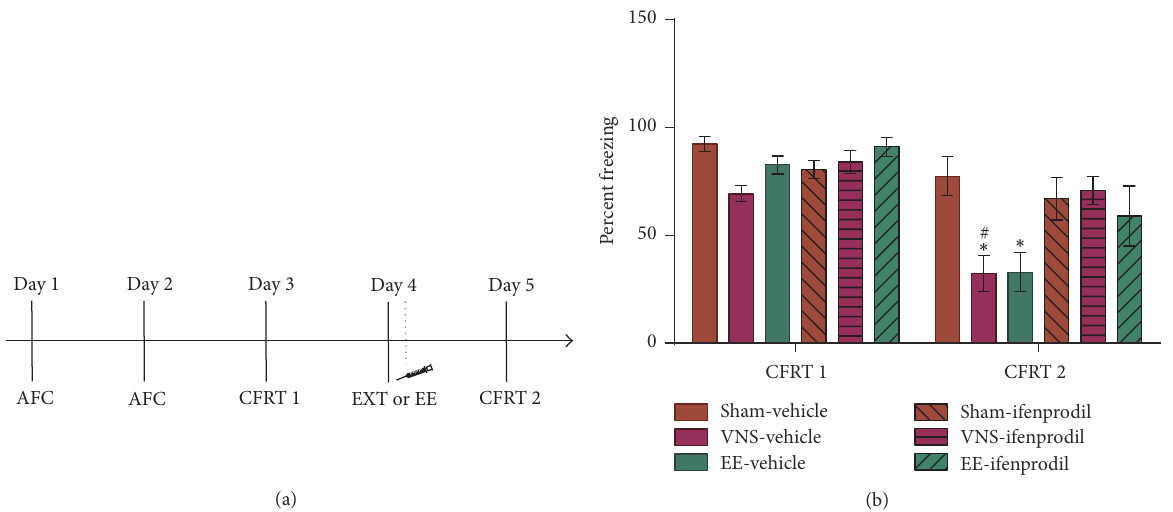
Figure 4: Ifenprodil blocks extinction learning in VNS-extinction and EE rats. (a) Timeline of behavioral protocol. On days 1 and 2 rats were subjected to auditory fear conditioning (AFC) followed by a conditioned fear response test (CFRT) on day 3. On day 4 rats underwent extinction training (EXT) or extended-extinction (EE) training that was immediately followed by an i.p. injection of ifenprodil or vehicle. On day 5 rats underwent a second CFRT (CFRT 2). (b) VNS-extinction and EE rats given a vehicle injection immediately after extinction training show a significant decrease in freezing levels during the second conditioned fear response test (CFRT 2) compared to sham-vehicle rats ( ∗ ). VNS-vehicle rats show significantly lower freezing levels during CFRT 2 compared to VNS-ifenprodil rats